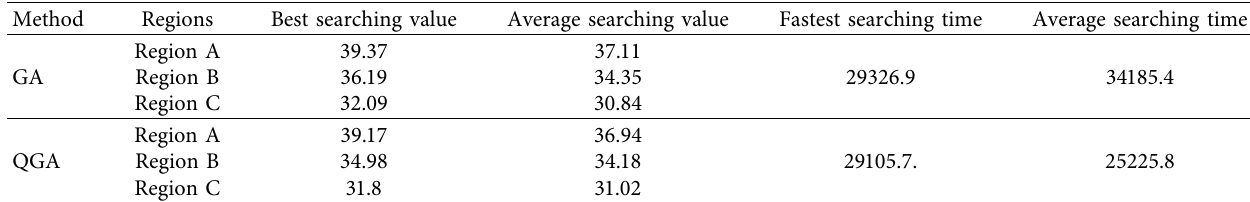
Table 1: Calculated results from inversion model by two optimization methods.